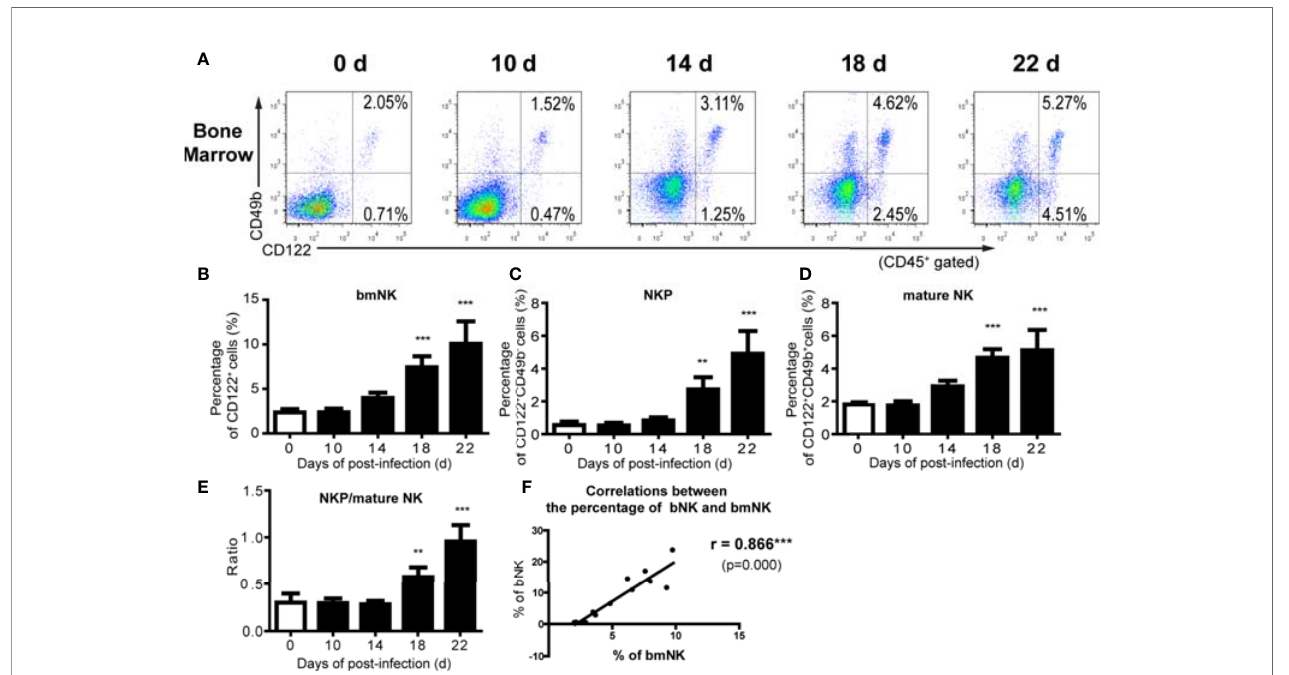
FIGURE 3 | The percentage of NK cells in bone marrow increased after A. cantonensis infection. (A – D) The percentage of NK cells in bone marrow lymphocytes of A. cantonensis -infected mice. NK cells in bone marrow (CD122 + ) were divided into NK precursor cells (CD122 + CD49b - ) and mature NK cells (CD122 + CD49b + ) detected by FCM. (E) The ratio of NK precursor cells to mature NK cells in bone marrow. (F) The correlation between the percentage of NK cells in bone marrow and brain. Data are expressed as the means ± SD. Data shown represent analysis from two independent experiments with three mice per group. Multiple comparisons of the percentage of NK cells at different time-points of infection were performed by one-way ANOVA. The ratio of different time points was analyzed by nonparametric test. The correlation between the percentage and number of NK cells in different tissues was analyzed by linear correlation. ** P < 0.01; *** P < 0.001, compared with that of 0 dpi. bmNK, NK cells in bone marrow; NKP, NK precursor cells; mature NK, mature NK